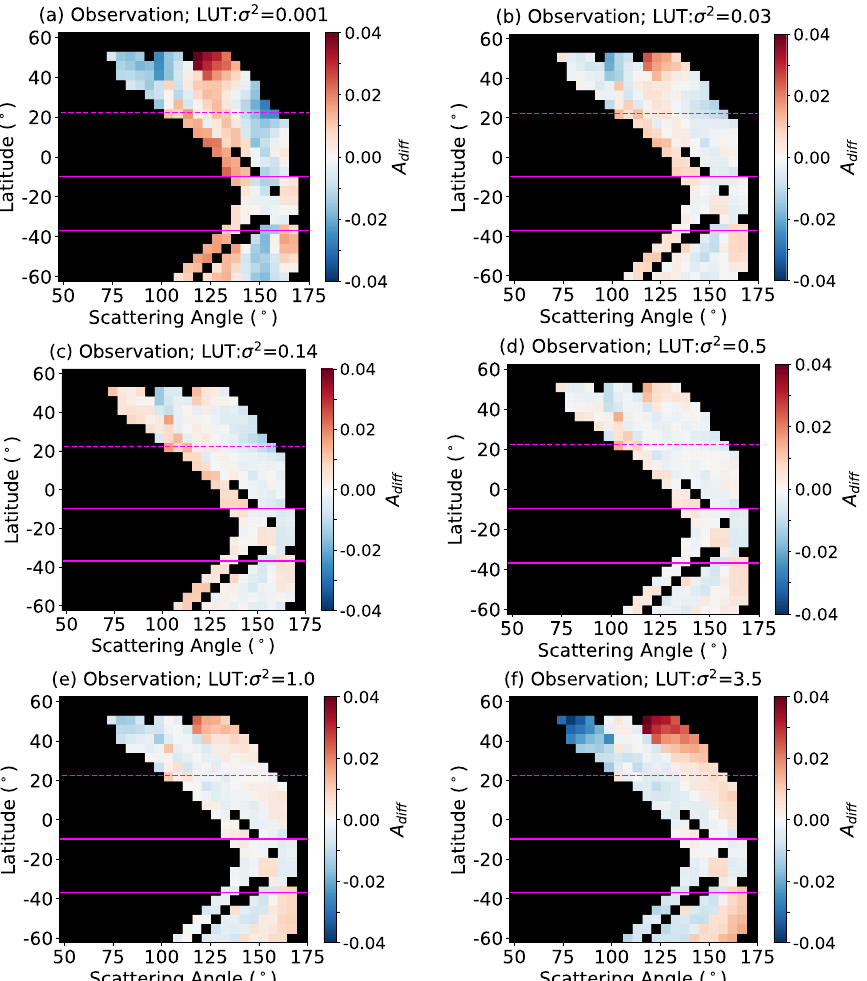
Figure 4. The median value of all spherical albedo differences ( A dif f ) in latitude-scattering angle bins on December solstices from 2012 to 2015 using ( a ) R0001, ( b ) R003, ( c ) R014, ( d ) R05, ( e ) R10, and ( f ) R35 ice particle models. The dashed and solid lines correspond to solar zenith angle (SZA) 50 ◦ and 30 ◦ ,